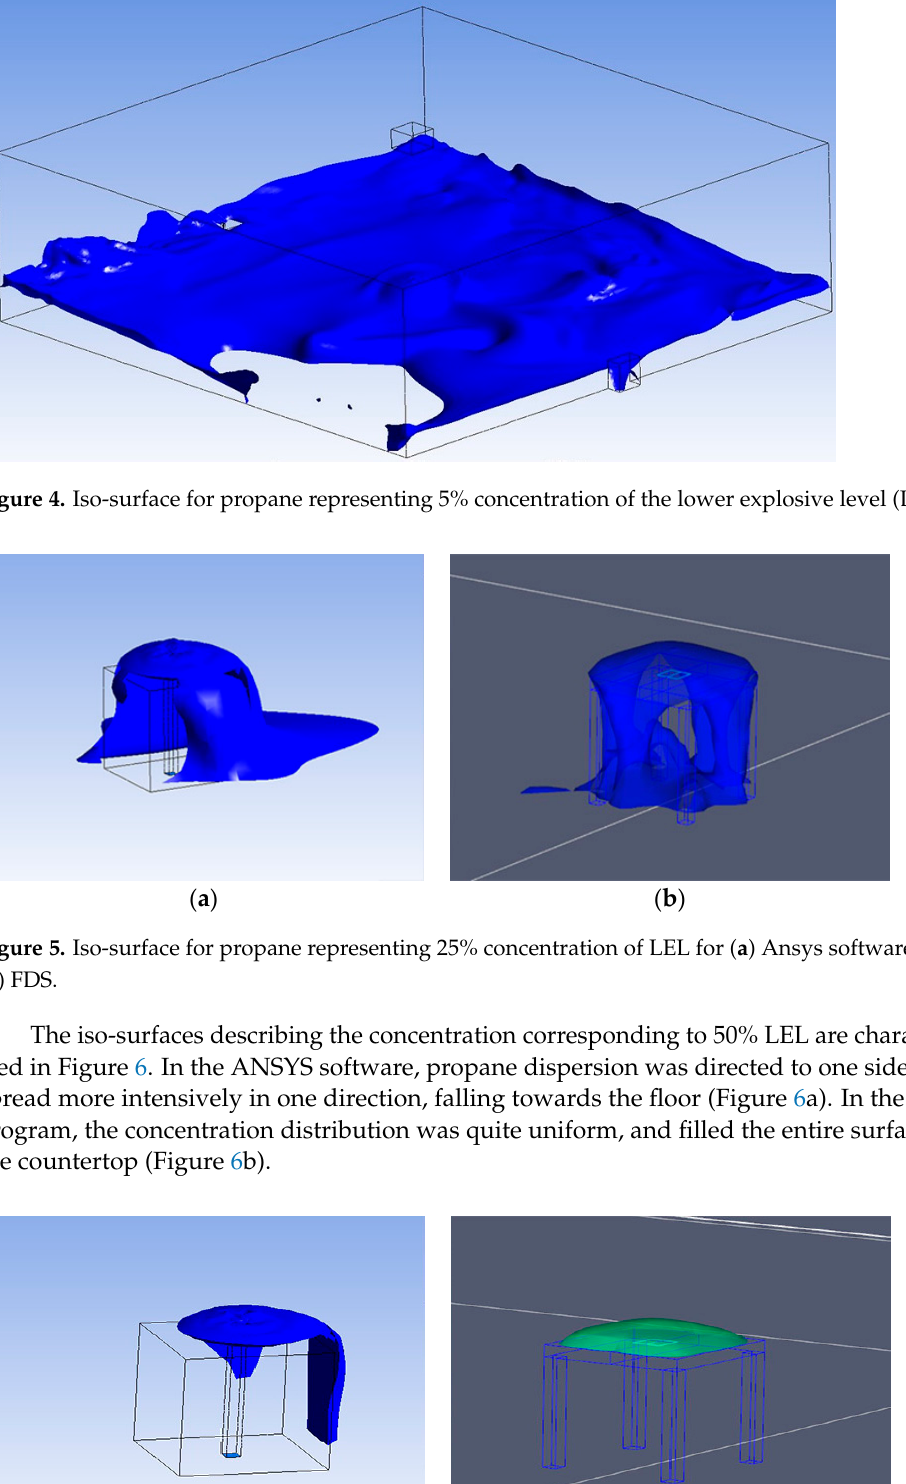
Figure 6. Iso-surface for propane representing 50% concentration of LEL for ( a ) Ansys software and ( b ) FDS.